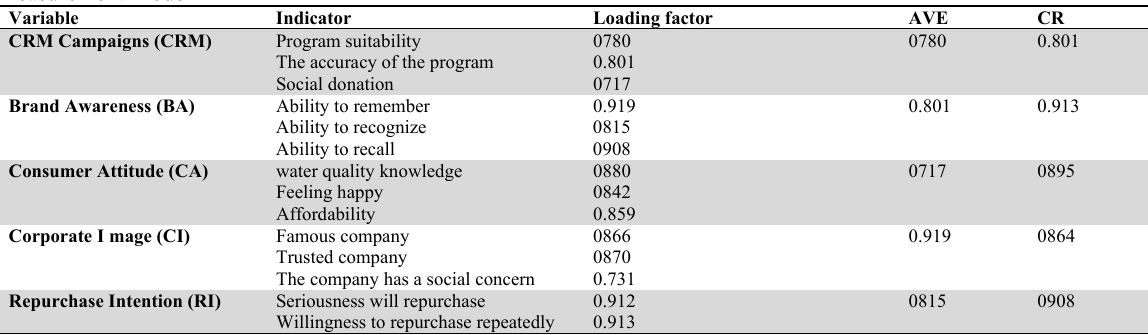
Measurement Model